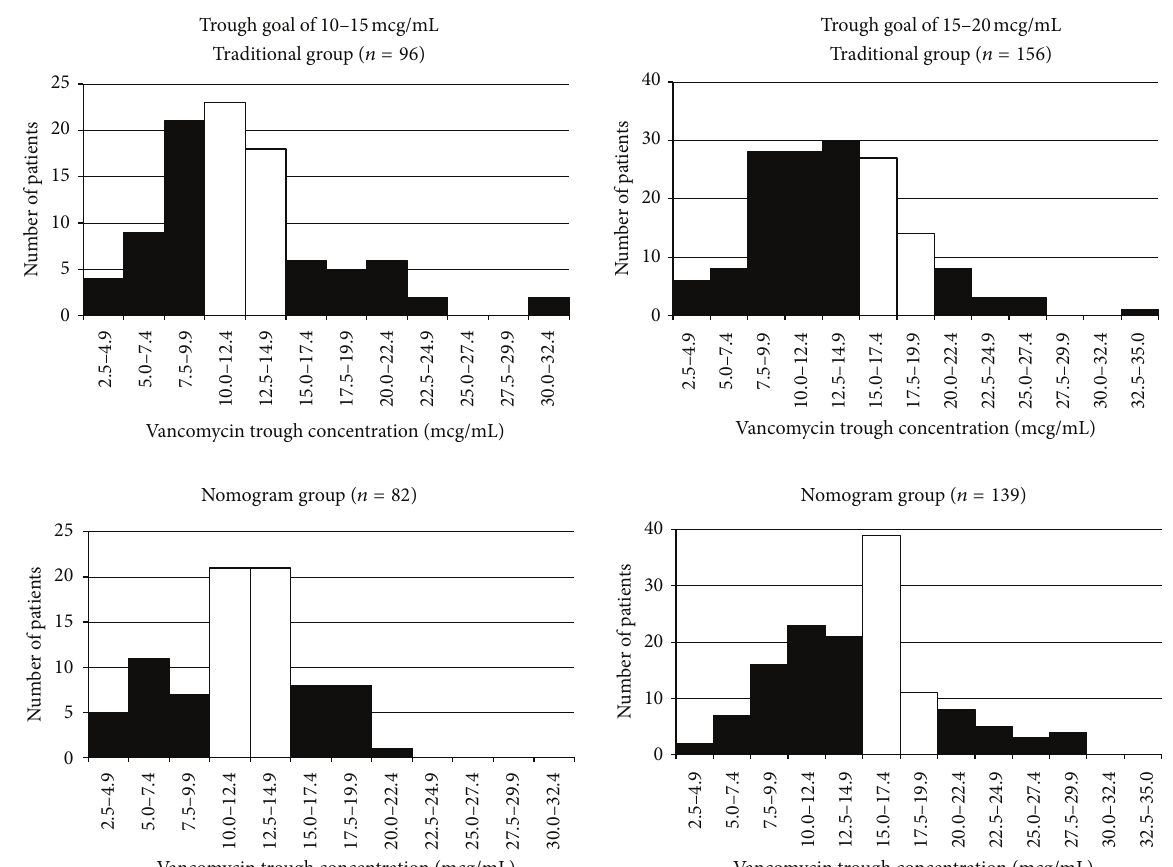
Figure 2: Distribution of vancomycin trough concentrations among treatment groups and target trough ranges. White bars represent patients in target trough range, and black bars represent patients who were out of the target range.